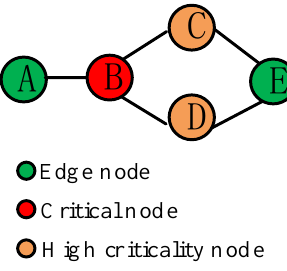
Figure 1. Example of high criticality nodes.